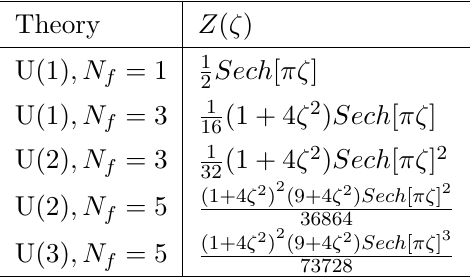
Table 1 . Exact result of the matrix integral for a partition function deformed by an FI term (cid:16) . examples are given in table 1. All these examples are \good" or \ugly", since